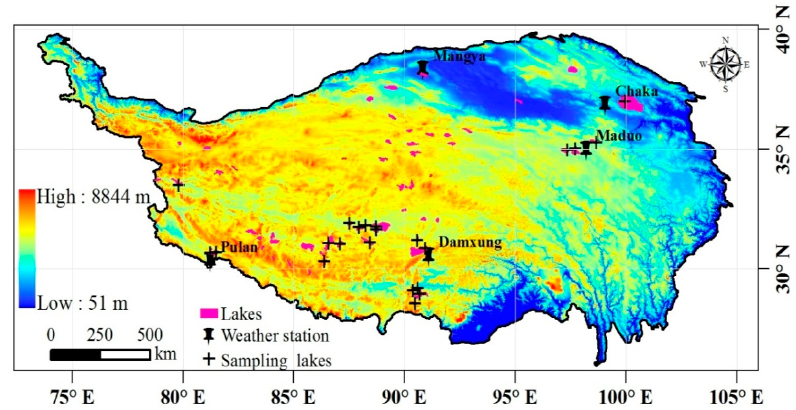
Figure 1 . The distribution of lakes (>50 km 2 ) concerned and the stations for validation dataset collection across the Tibetan Plateau.